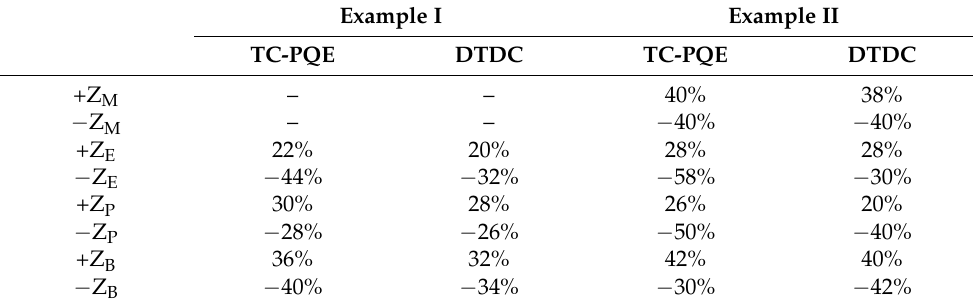
Table 5. Maximum feed composition disturbances handled by the DTDC and TC-PQE schemes (Examples I and